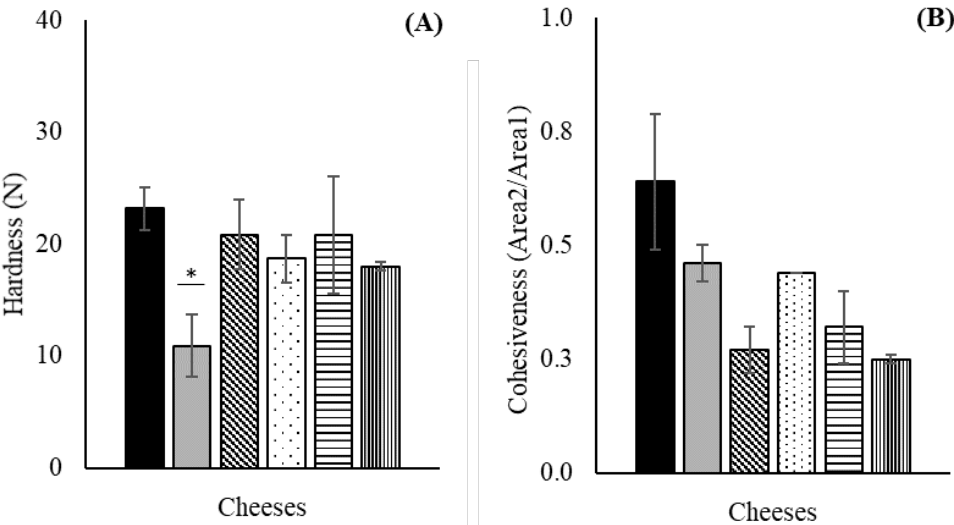
Figure 2. Texture attributes of costeño-type cheese: ( A ) hardness; ( B ) cohesiveness. Q C (black bar), Q 1 (gray bar), Q 2 (diagonal striped bar), Q 3 (point bar), Q 4 (horizontal striped bar), and Q 5 (vertical striped bar). Error bars represent standard deviation. Student’s t -tests were performed to assess significance compared to the control cheese (Q C ), where (*) corresponds to a p -value < 0.05, and (**) to a p -value < 0.01.